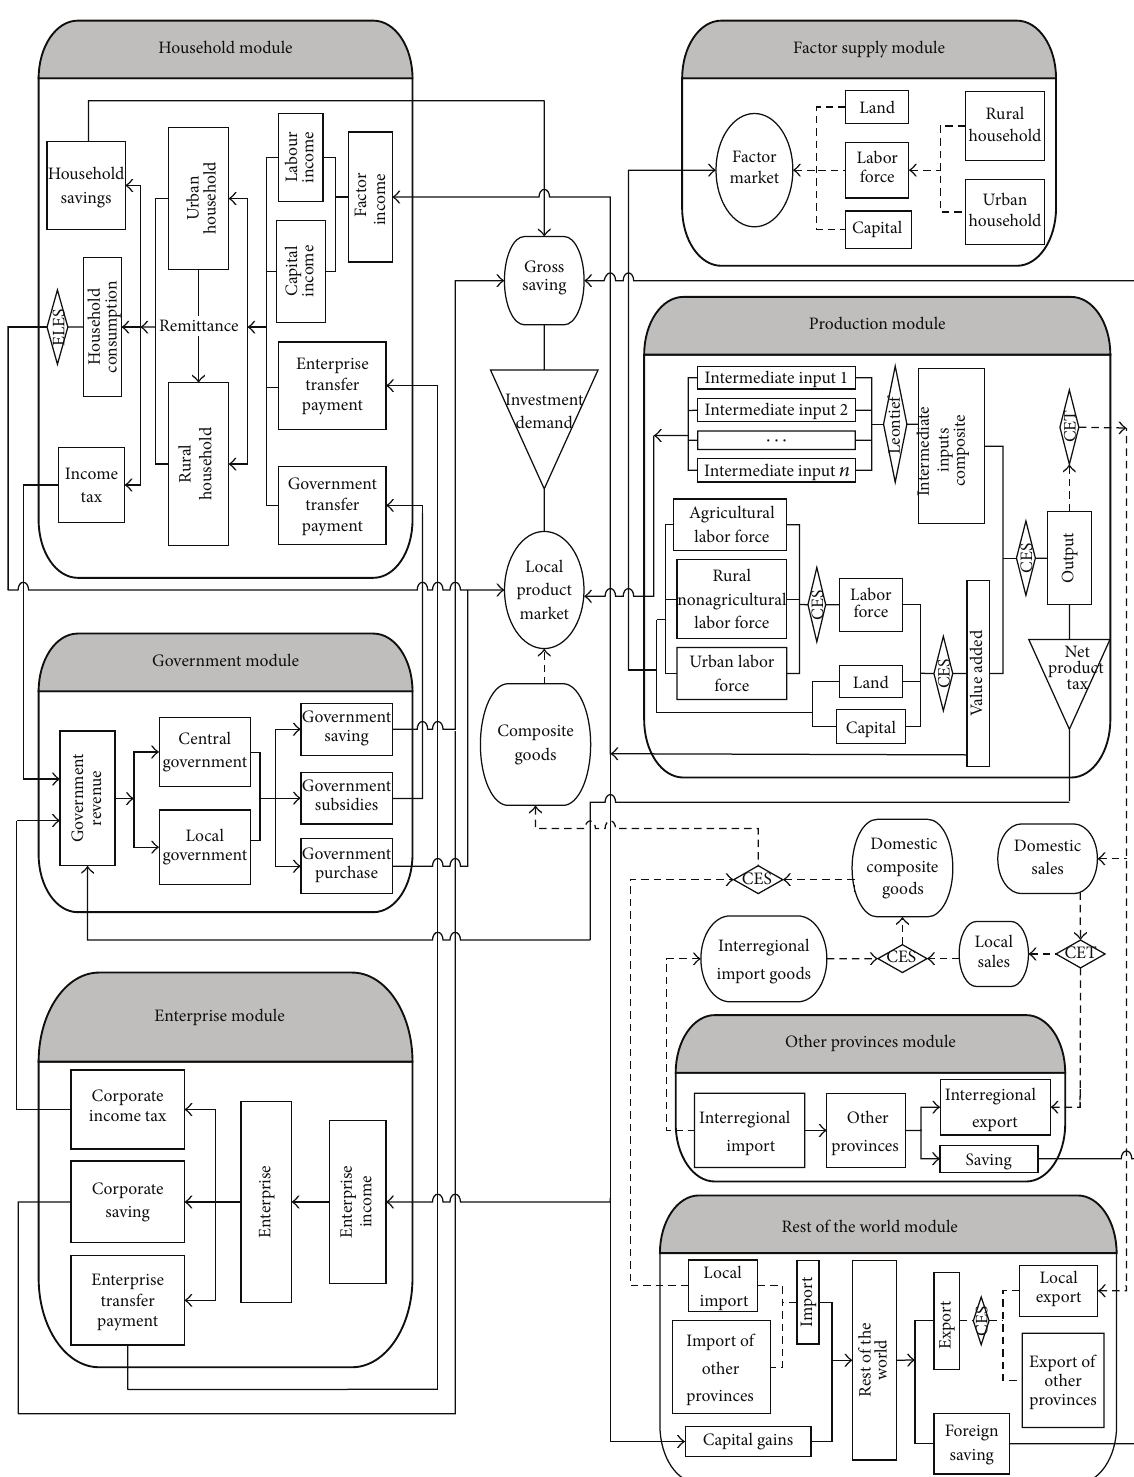
Figure 1: Structure of CGE